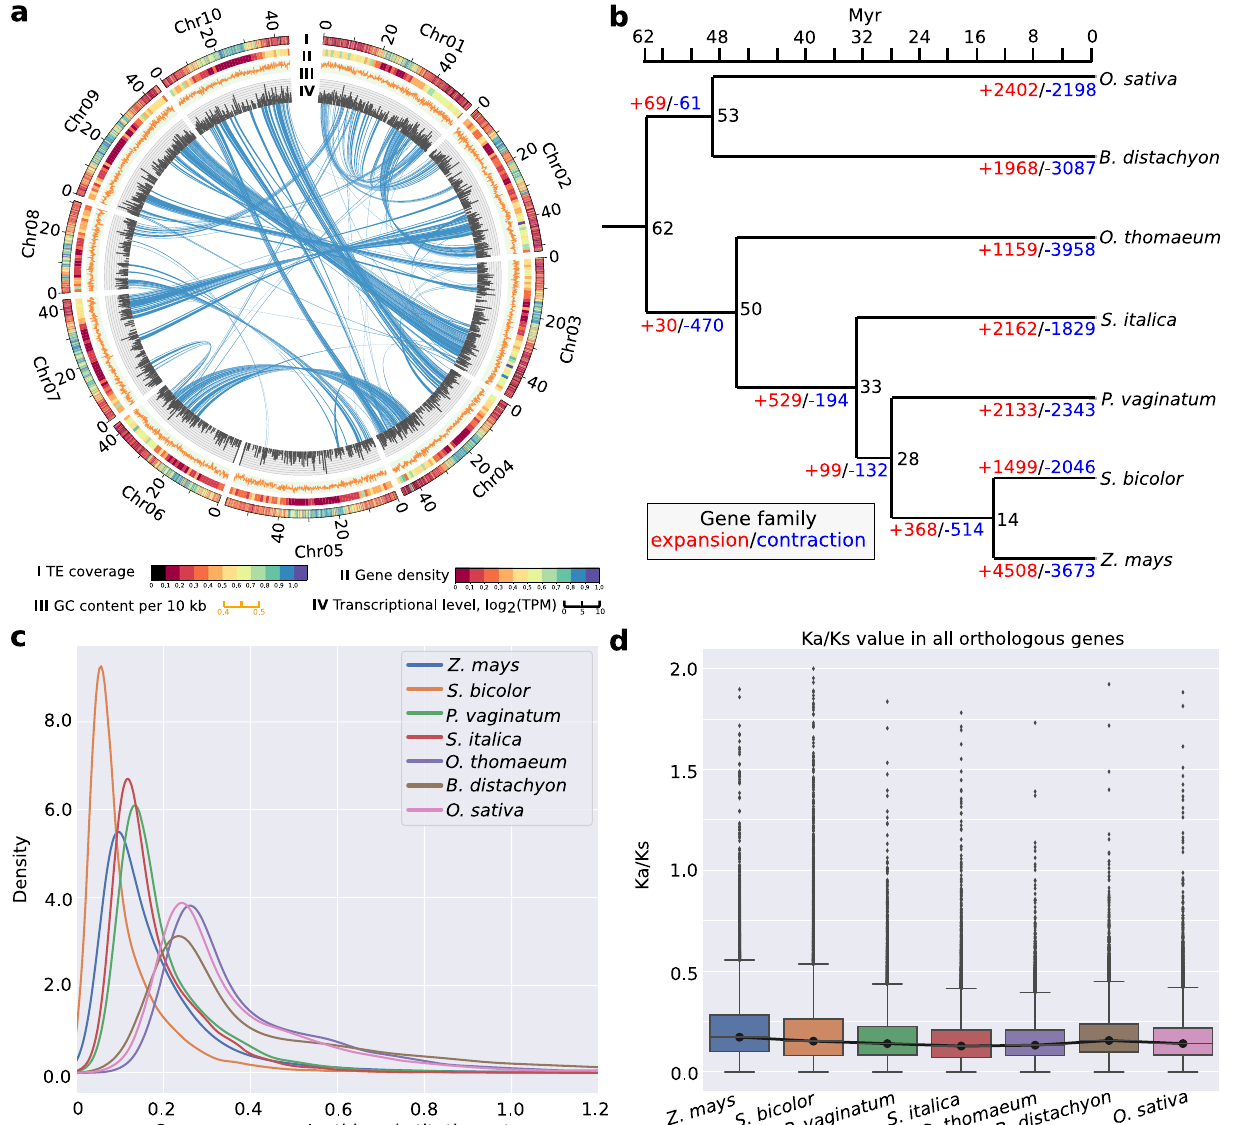
Fig. 1 | Paspalum ( Paspalum vaginatum ) genome and evolution. a Properties of the paspalum genome. Layers in circos plots are (I): TE (transposable element) coverage per 100 Kb, (II): gene density (proportion of sequence covered by annotatedgenes)per1Mb(megabase),(III):GCcontentper10kb(kilobase)region, (IV): transcription represented by log 2 (TPM (transcripts per million)) per 100kb. Green lines indicate inter- and intra- chromosomal synteny. b Phylogeny and esti- mated divergence times among maize ( Zea mays ), sorghum, paspalum, foxtail millet ( Setaria italica ), Oropetium ( Oropetium thomaeum ), Brachypodium ( Brachy- podium distachyon ), and rice ( Oryza sativa ). Numbers in black indicate the esti- mated divergence time in millions of years before present (Myr) for each node. Numbers in blue and red indicate the number of gene families predicted to have experienced copy number expansion or contraction along each branch of the